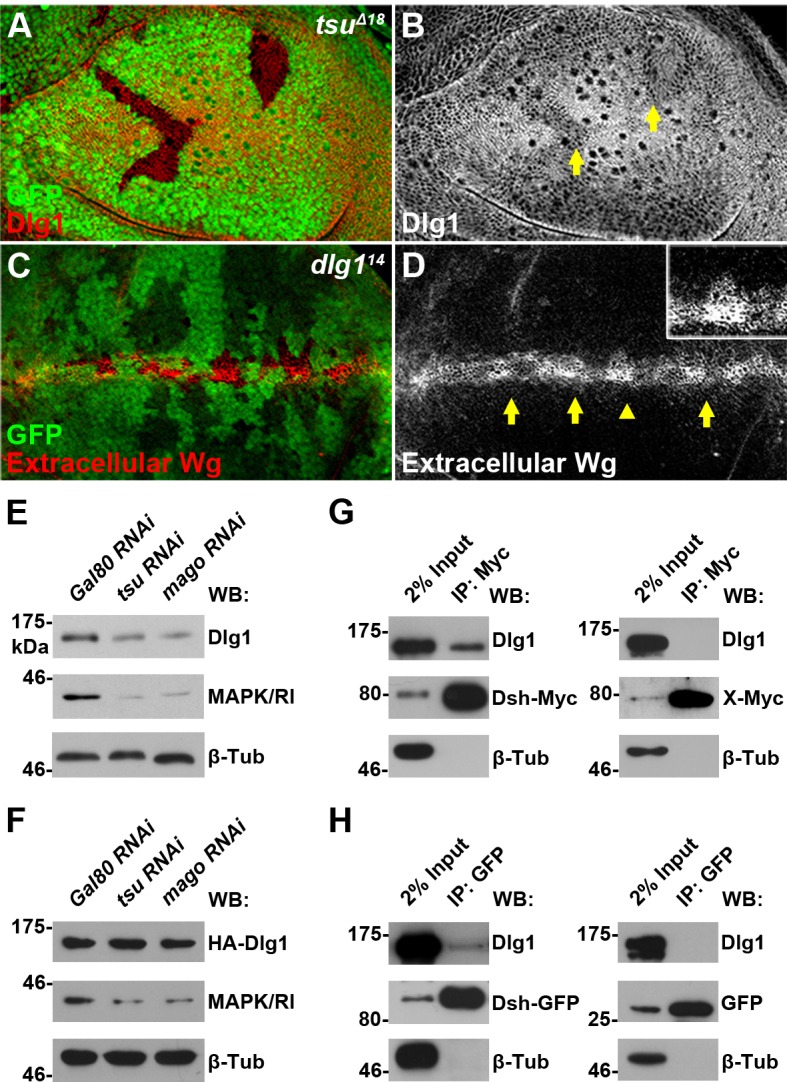
The pre-EJC regulates Dsh-interacting protein Dlg1.(A,B) The expression of endogenous Dlg1 protein was reduced in tsuΔ18 clones (indicated by an arrow). (C,D) Extracellular Wg was accumulated in dlg114 clones. Shown in the inset is an enlarged clone with accumulated extracellular Wg. (E,F) The amount of endogenous (E) but not a cDNA-derived Dlg1 protein (F) was reduced when tsu or mago dsRNA was expressed in S2 cells. MAPK/Rl served as a positive control for dysfunctional pre-EJC activity. (G,H) Endogenous Dlg1 interacted with Myc-tagged Dsh in S2 cells (G) and GFP-tagged Dsh in wing discs expressing the dsh-gfp under the control of the dsh promoter (H). A Myc-tagged irrelevant protein X or GFP alone served as negative controls, respectively.